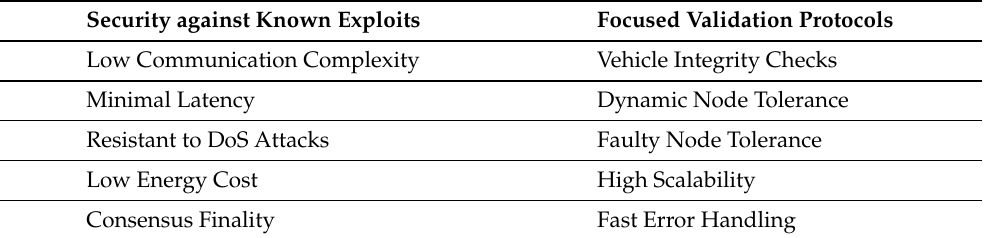
Table 2. Considerations for consensus protocol involving